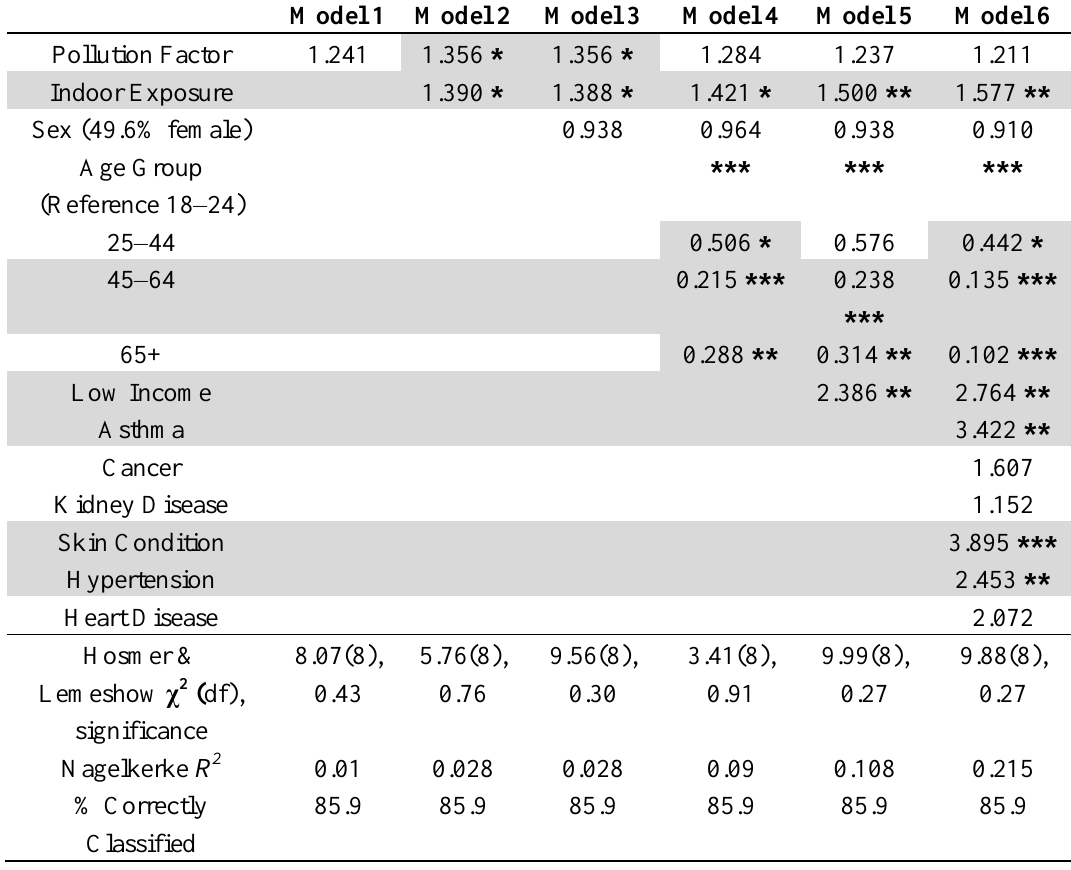
Table 5. Odds ratios for 5+ cardinal symptoms—no allergies or hay fever (n =